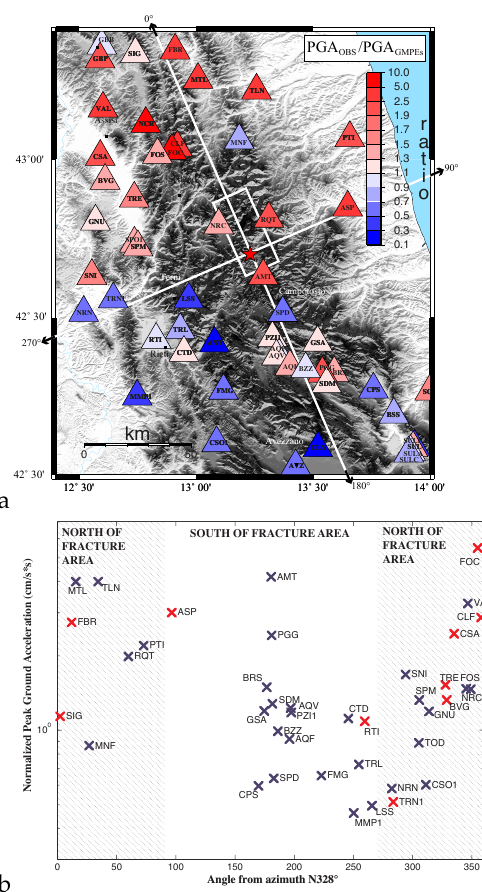
Figure 4. (a) PGV ratio (PGV /PGV ) areal distri- OBS ITA10 bution at the 98 considered stations of RAN and (b) PGV versus azimuth in a modified geographic refer- ence system, similarly to Figure